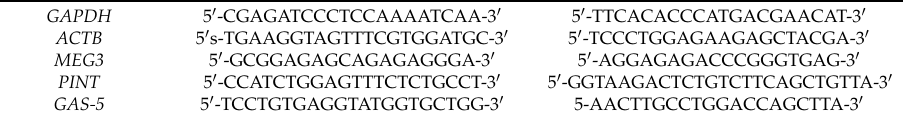
Table 4. LncRNA Primer